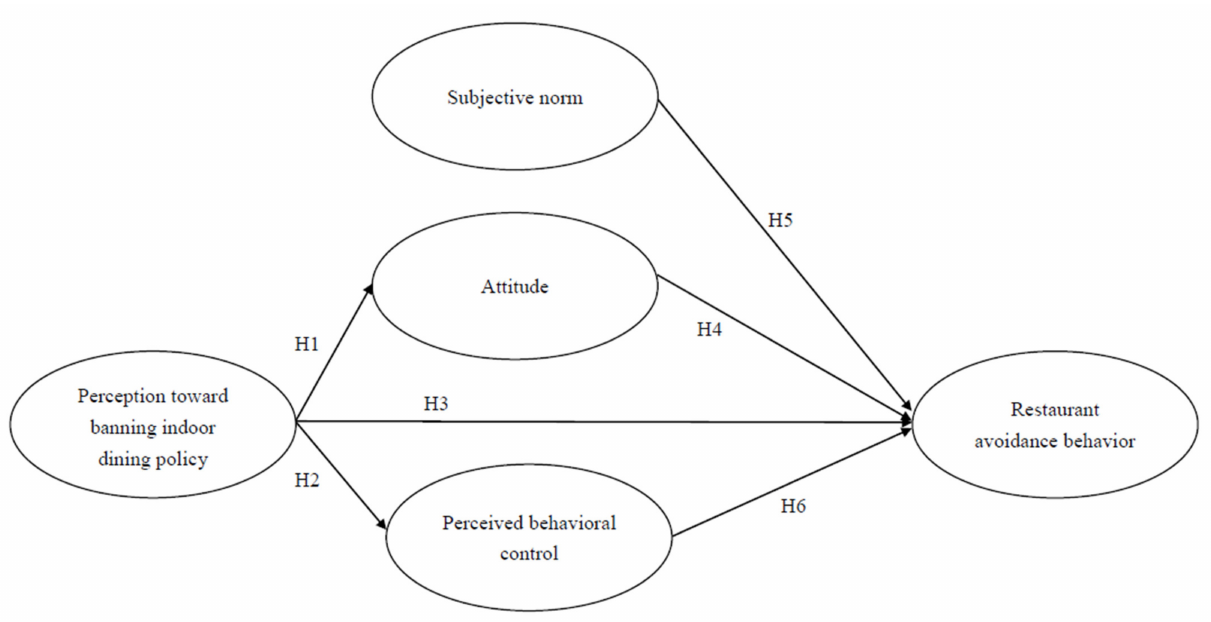
Figure 1. Research